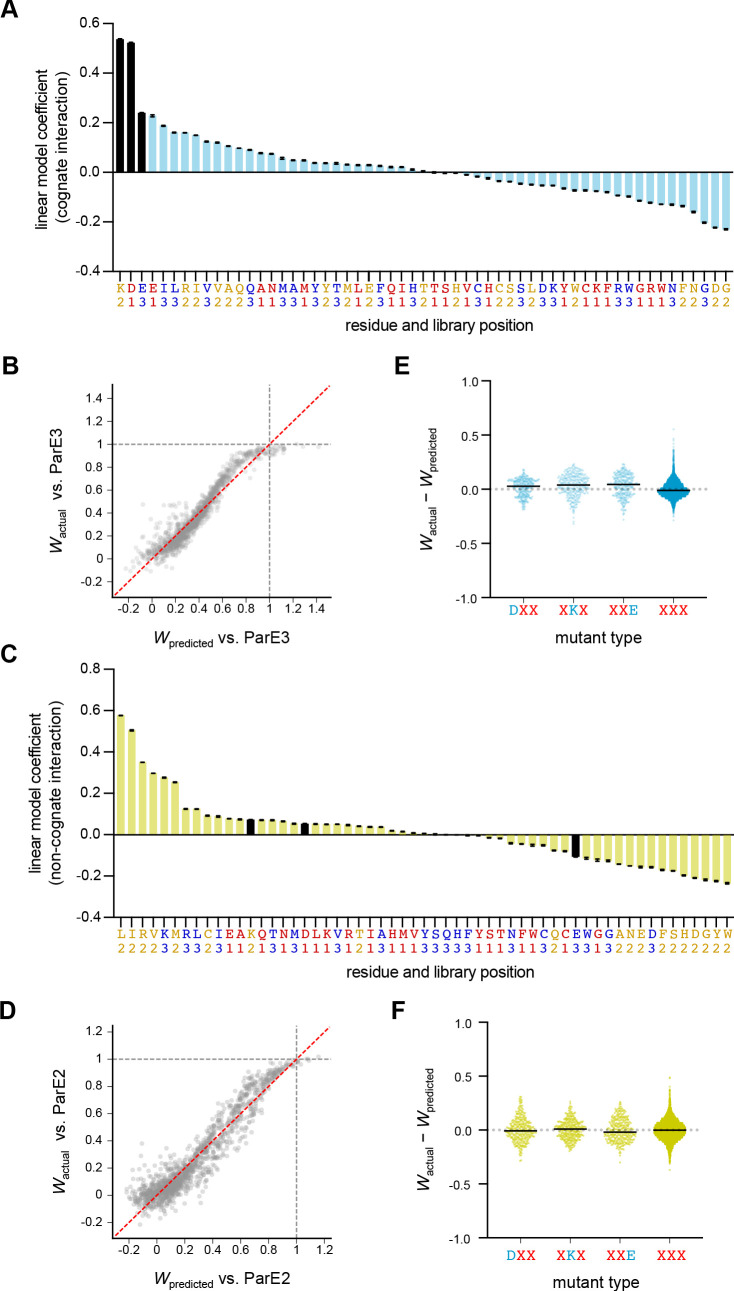
A linear model predicts variant fitness.(A) All coefficients for a linear model (see text and Materials and methods for details) predicting variant fitness against ParE3, assuming additivity between library positions. Error bars indicate standard deviations from five-fold cross-validation. Wild-type ParD3 residues are black. (B) Observed fitness values for library variants are plotted against the predicted values from the linear model. Data are from one representative fold. The y = x line is plotted in red. (C–D) Same as in (A–B), but for variant fitness against ParE2. (E–F) Difference between actual and predicted fitness versus. ParE3 (E) or ParE2 (F) calculated from the linear model for double and triple mutants.